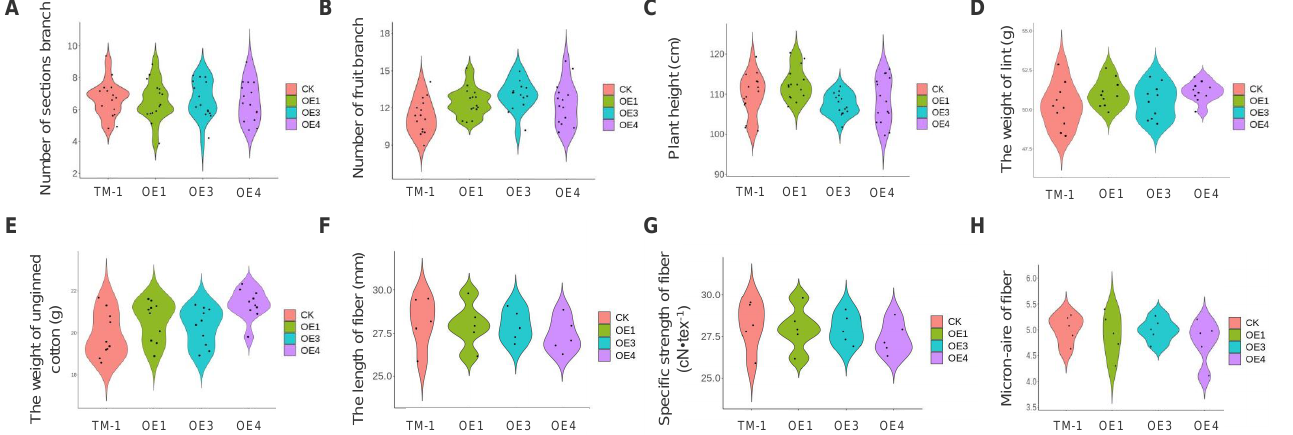
Figure 7. Physiological indexes of TM-1, OE1, OE3, and OE4 plants at various growth periods. ( A ) Number of sections. ( B ) Number of fruits. ( C ) Plant height. ( D ) Weight of lint. ( E ) Weight of unginned cotton. ( F ) Length of fiber. ( G ) Specific strength of fiber. ( H ) Micronaire of